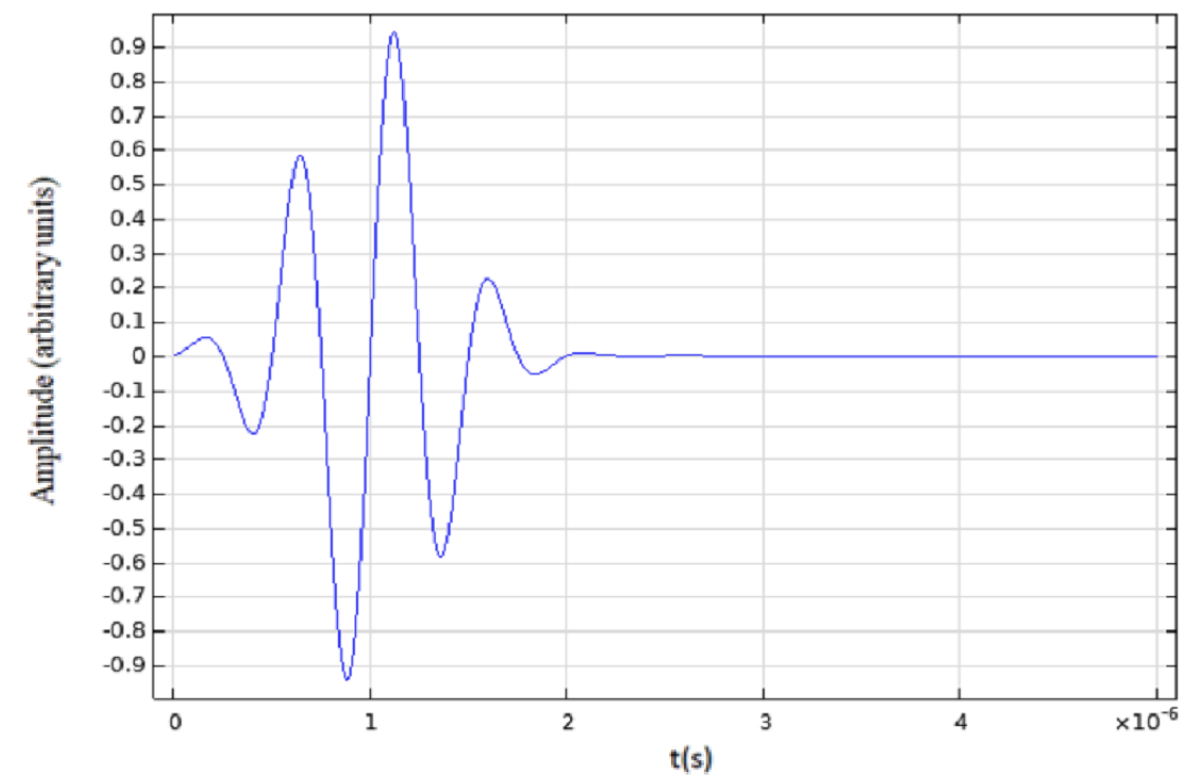
Figure 5. Initial emitted ultrasonic pulse. Sinus function with 2 π f 0 t argument modulated by Gaussian envelope Central and frequency f 0 = 2 MHz.